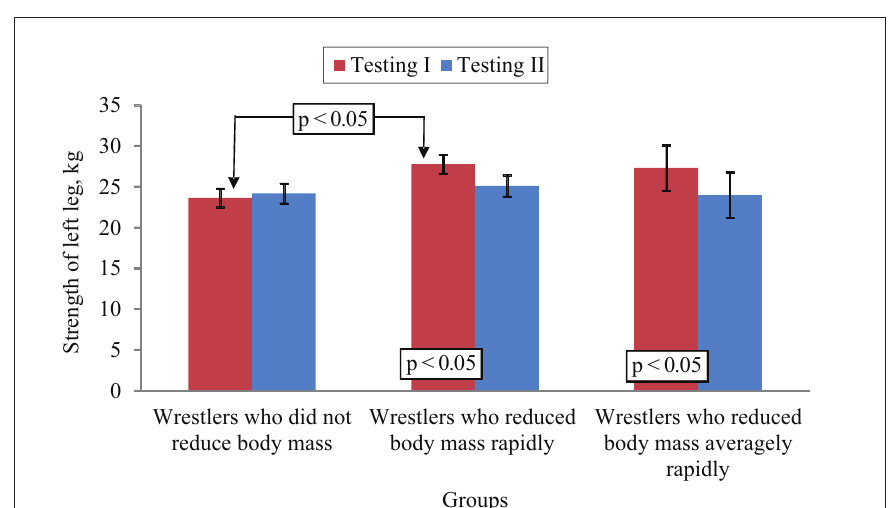
Figure 4. Wrestlers’ left leg